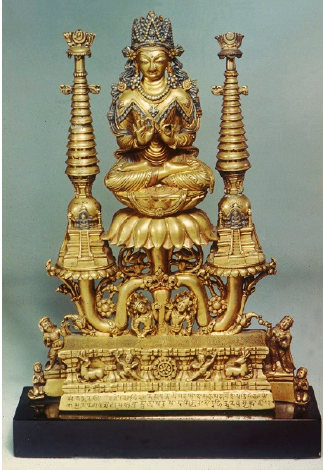
Figure 6. Buddha wearing a crown and cape with crescent moon and sun symbols performing the dharmacakra-pravartana mudr ā . Commissioned by Sa ṃ karase ṇ a and the princess Devasr ī , April 20, 714 C.E. Gilgit. Brass with inlays of copper, silver, and zinc. 12 ¼ in. H. (31.1. cm). Asia Society, New York: Mr.and Mrs. John D. Rockefeller 3rd Collection (1979.44).